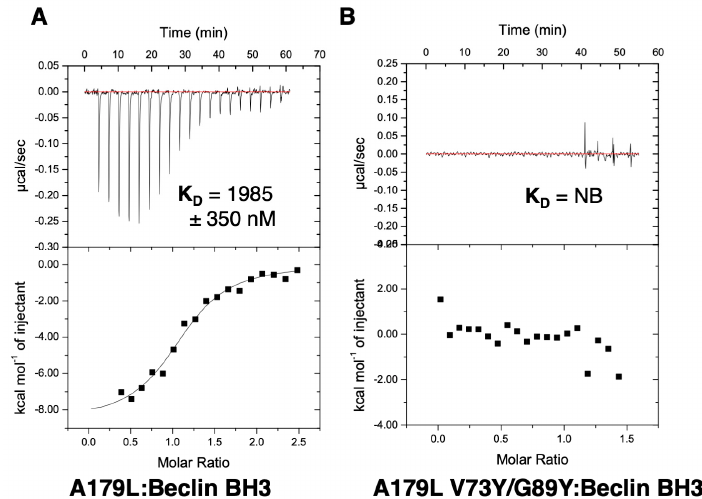
Figure 5. Isothermal titration calorimetry-binding profiles of ( A ) A179L as well as ( B ) A179L V73Y/G89Y interaction with Beclin BH3 peptide. Raw thermogram and a binding isotherm fitted with a one-site binding model are shown. All experiments were performed in triplicate. Data for wildtype A179L are from [44]. K D : Dissociation constant; ± : Standard deviation; NB: No binding.